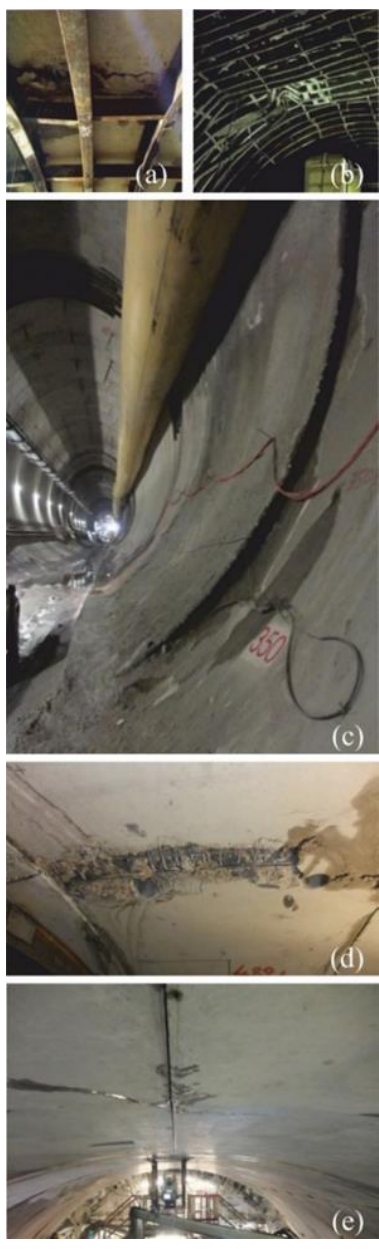
Figure 7. Damages on the segments and the reinforcement with NPI profiles ( a , b ); additional sup- ports; steel-beam, wire mesh, and fiber-concrete shotcrete ( c ); an example photograph representing excessive plastic deformation in the tunnel ( d ); an example view of a longitudinal joint in the tunnel ( e ).